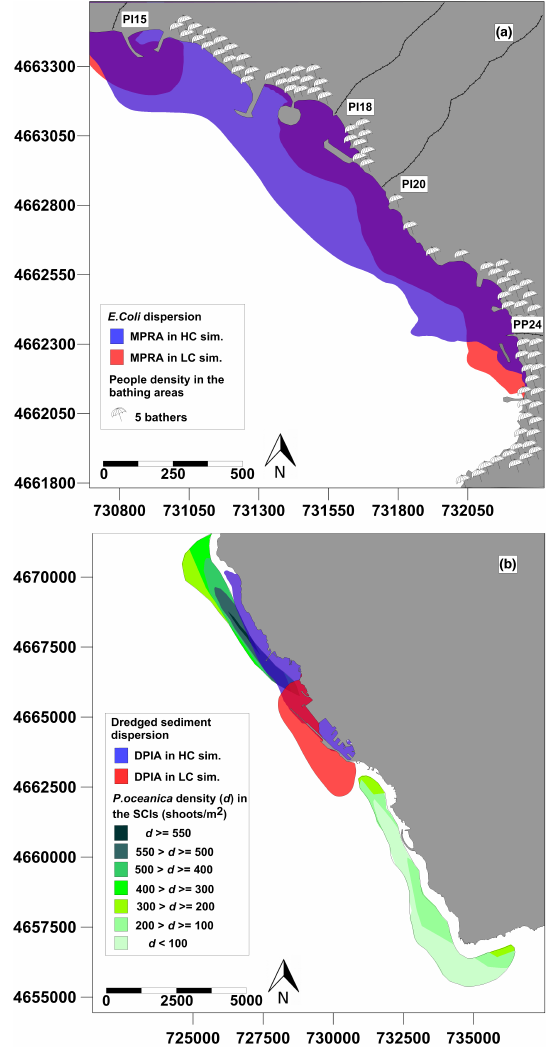
Figure 7. Overlap between anthropic pressures indicated by the po- tentially polluting zoning indicators (MPRA and DPIA) and sensi- tivity areas represented as thematic maps to analyze urban discharge bathing area (a) and dredging SCI (b)